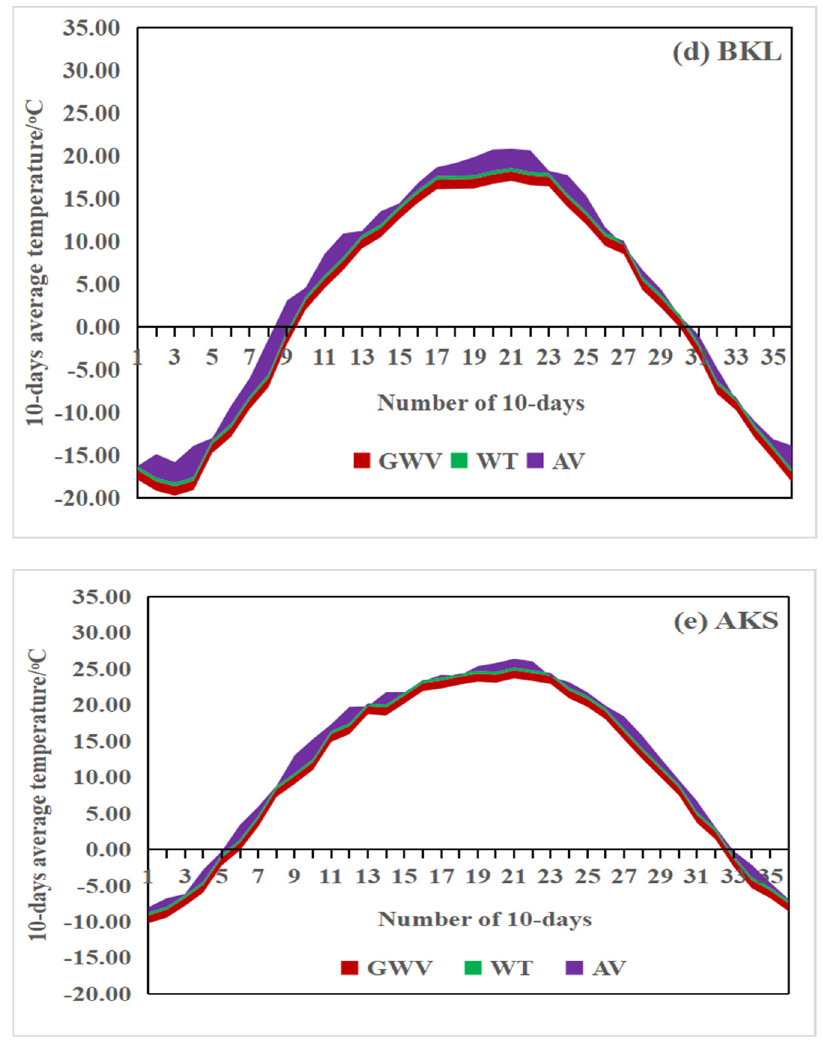
Figure 3. The intra-annual changing pattern of AV in GWV 2011–2020 : the global warming during 2011–2020, 1.09 °C; WT: the warming target, 1.5 °C; AV: the amplitude of variation. ( a ) CTMR; ( b ) SHSJF; ( c ) TLF; ( d ) BKL; ( e ) AKS.